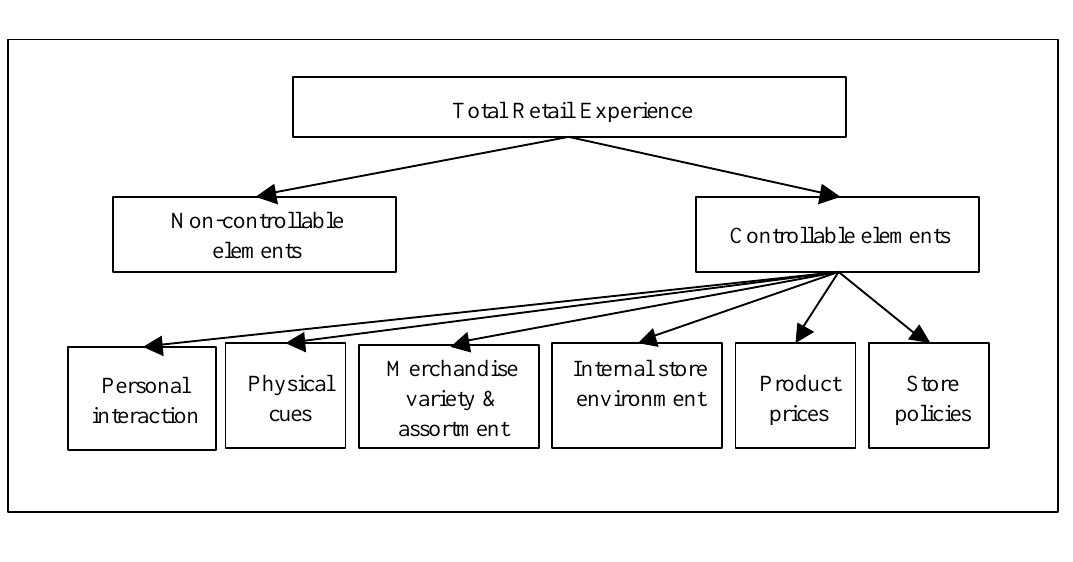
Figure 2 Schematic presentation of the dimensions of the TRE tested in the second phase of the